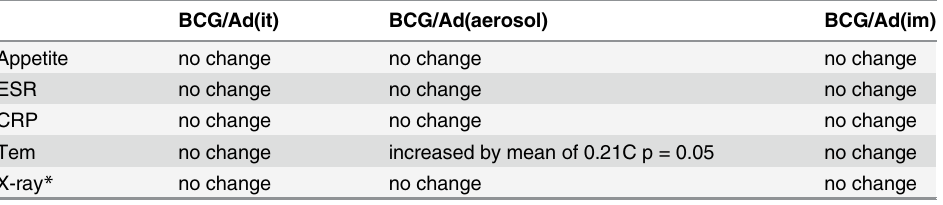
Table 2. Clinical outcomes post-AdHu5Ag85A boost vaccination.